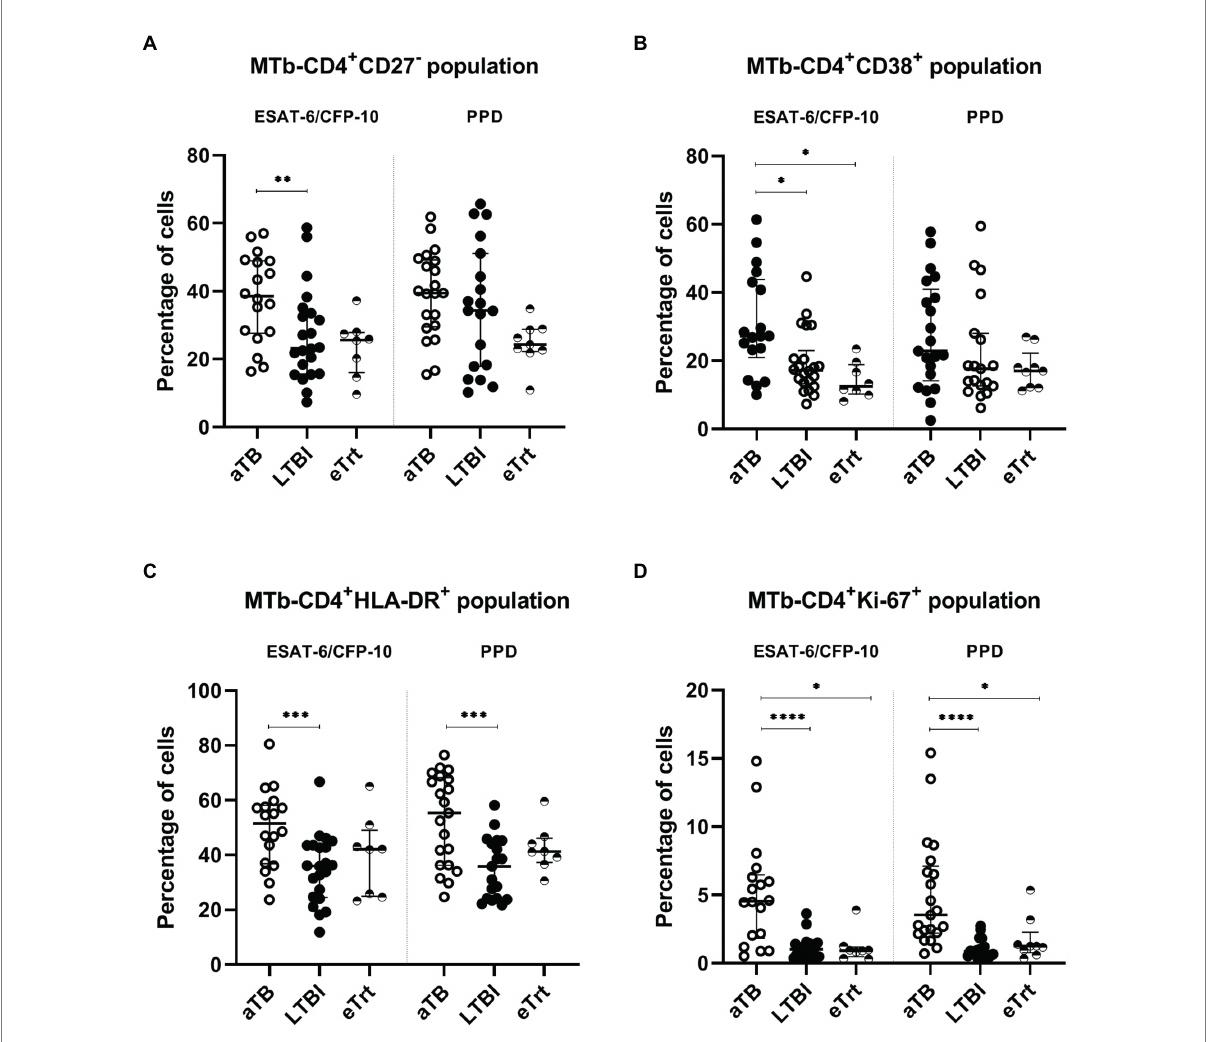
FIGURE 1 CD27 − , CD38 + , HLA-DR + , and Ki67 + phenotype from Mtb-specific CD4 + T-cells of each patient group. Percentage of CD27 − (A) , CD38 + (B) , HLA- DR + (C) , and Ki67 + (D) within TNF- α + and/or IFN- γ + CD4 + T-cells after stimulation with ESAT-6/CFP-10 or PPD (left and right half of graph, respectively) in patients with active TB in the beginning and end of treatment, as well as LTBI individuals. Data plotted with median and interquartile range. Differences between aTB and LTBI conditions were calculated using the two-tailed Mann–Whitney U -test. Differences between aTB and eTrt groups were calculated using a mixed statistical model controlling repeated measures on logit-transformed data. * p < 0.05, ** p < 0.01, *** p < 0.001, **** p < 0.0001. No indication of p value implies non significance. aTB, active TB; LTBI, latent tuberculosis infection; eTrt, aTB patients after anti-TB